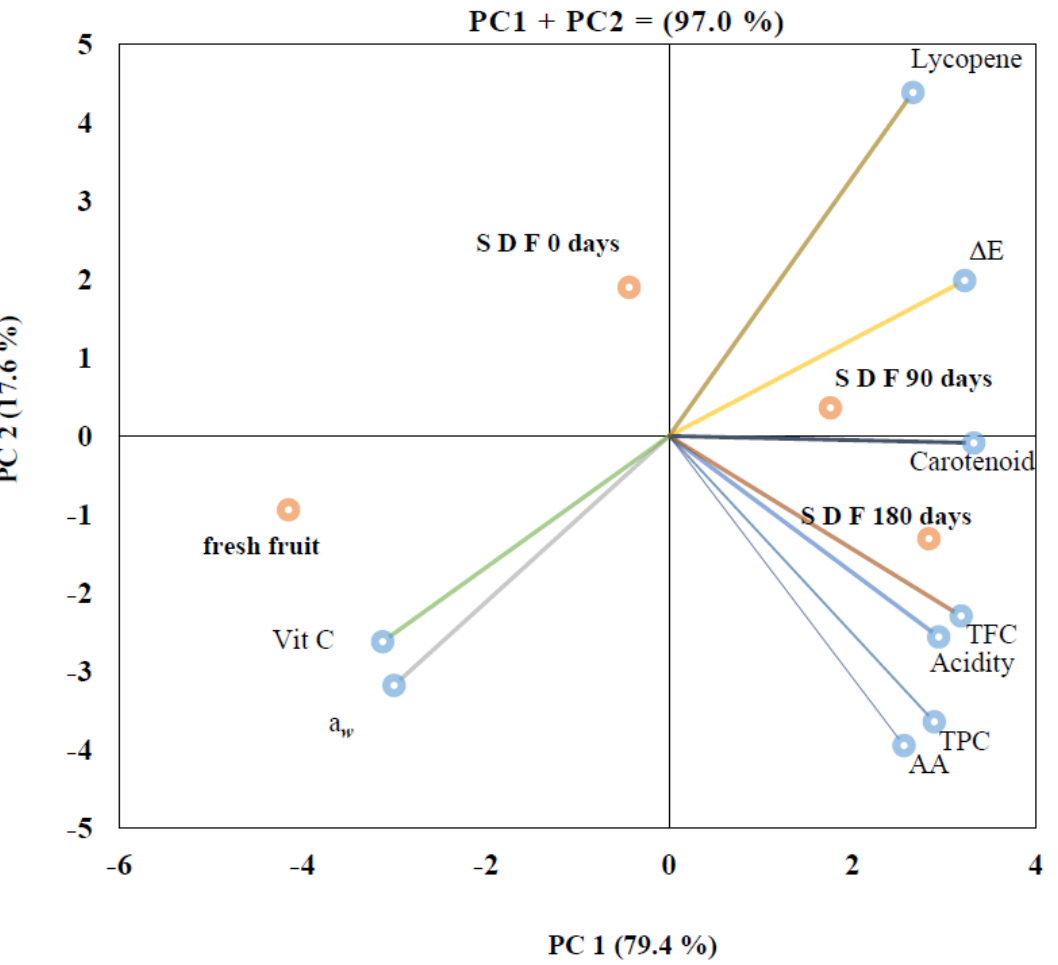
Figure 1. Principal component analysis (PCA) of color ( ∆ E), a w , total acidity, vitamin C content, total carotenoids, lycopene content, TPC, TFC, and AA of fresh fruit, solar-dried fruit (S D F 0 days), solar-dried fruit stored for 90 days (S D F 90 days), and 180 days (S D F 180